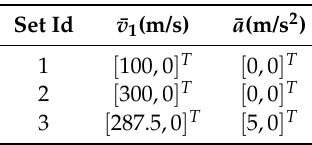
Table 1. The set of ¯ v 1 and ¯ a